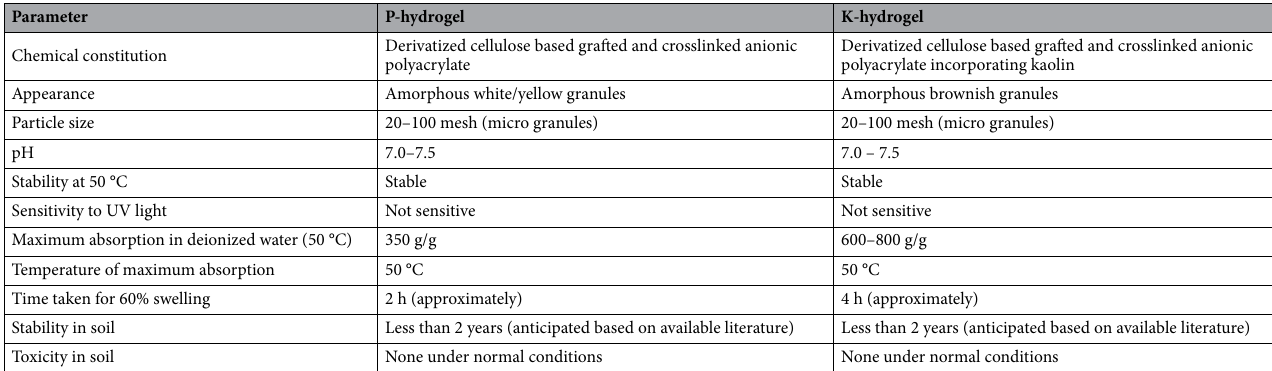
Table 5. Key characteristics of P- and K-hydrogels. Adopted from 50 .